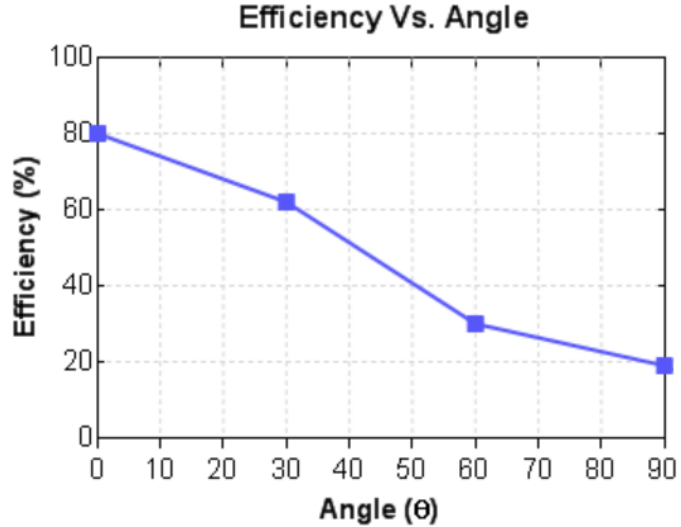
Figure 21. Efficiency variation across angles.